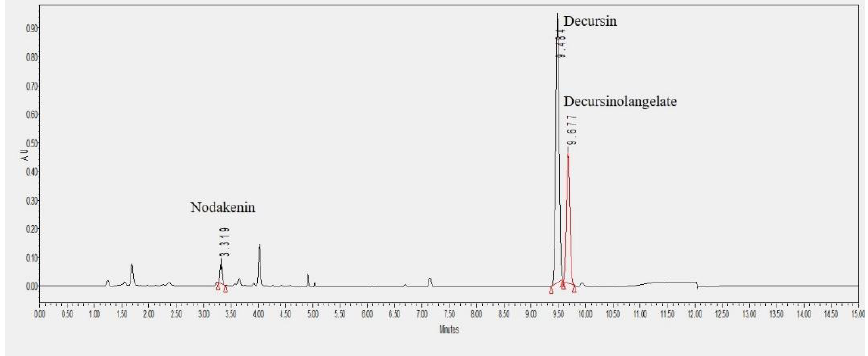
Figure 1. UPLC chromatogram of indicator components for the Angelica gigas samples.